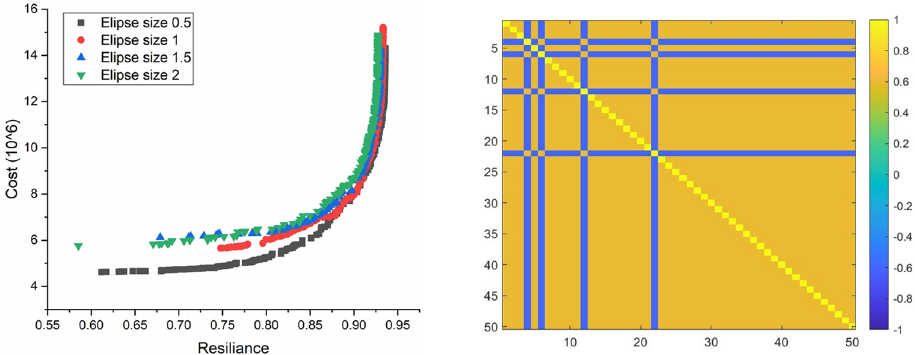
Figure 7. Pareto front obtained for different ellipsoidal sizes with demands related with co-variance matrix (3) shown adjacent.